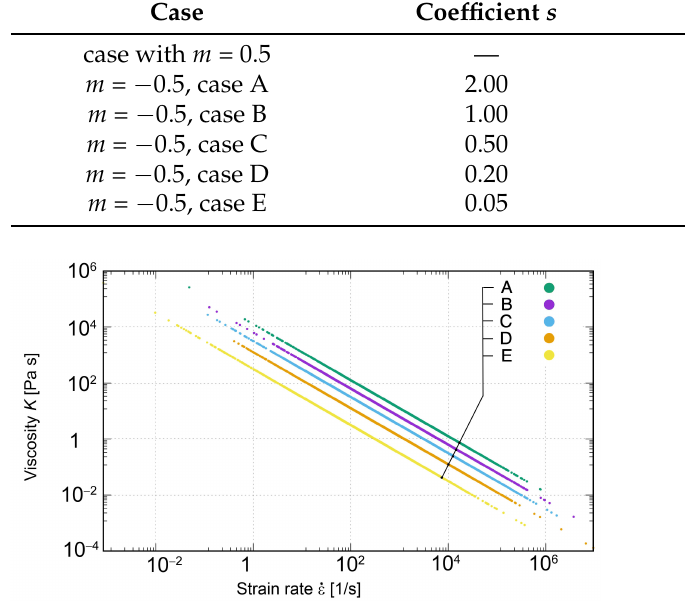
Figure 7. Relation between viscosity K and the strain rate ˙ ε for softening